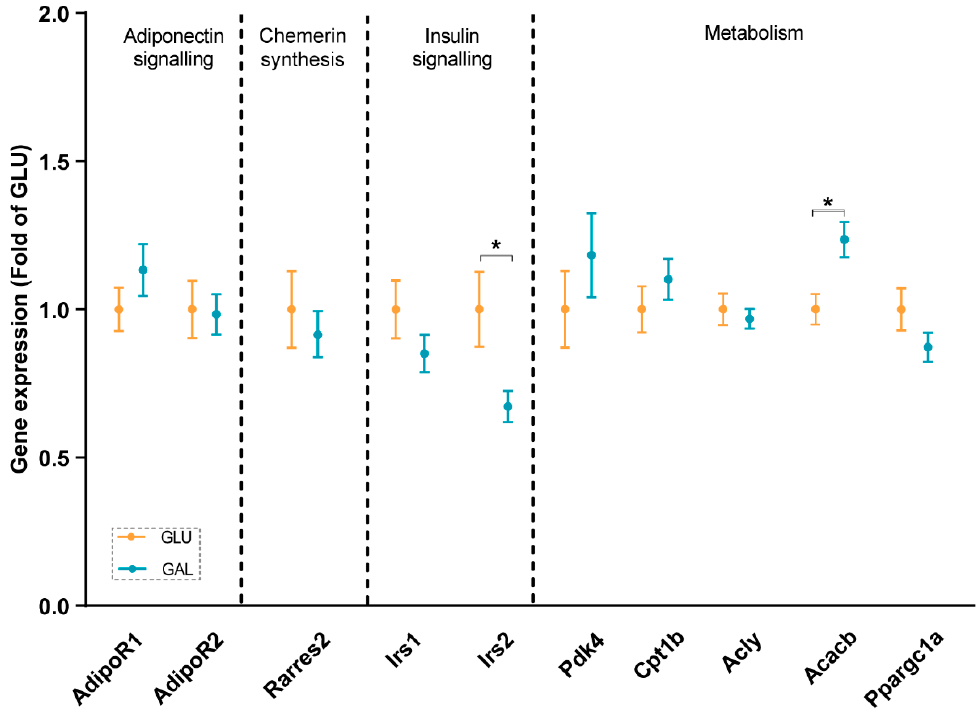
Figure 5. Skeletal muscle gene expressions in GLU and GAL mice followed by nine weeks of a HFD feeding. AdipoR1 : adiponectin receptor 1; AdipoR2 : adiponectin receptor 2; Rarres2 : retinoic acid receptor responder 2; Irs1: insulin receptor substrate 1; Irs2: insulin receptor substrate 2; Pdk4 : pyruvate dehydrogenase kinase 4; Cpt1b : carnitine palmitoyltransferase 1b; Acly : ATP citrate lyase; Acacb : acetyl-CoA carboxylase beta; Ppargc1a : peroxisome proliferative activated receptor, gamma, coactivator 1 alpha. Values are expressed as mean ± SEM (n = 13–14). * p < 0.05.